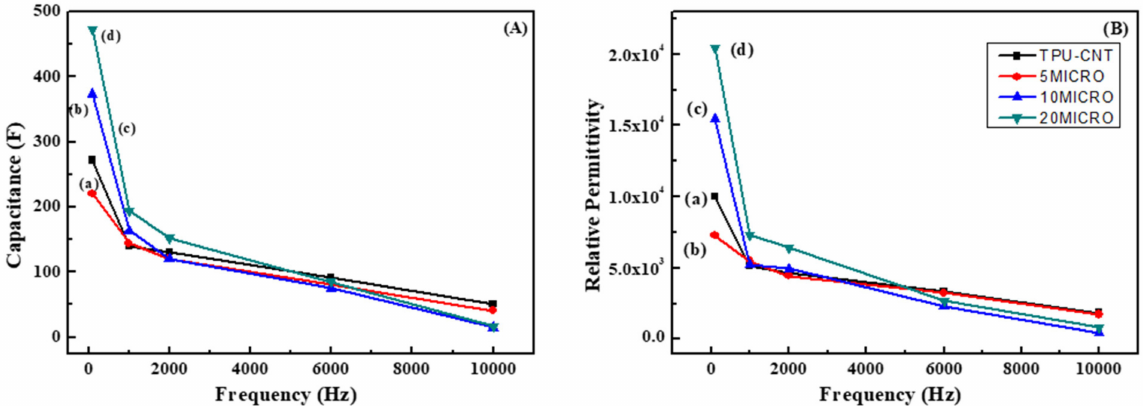
Figure 7 . Capacitance ( A ) and relative permittivity ( B ) of ( a ) TPU-MWCNT, ( b ) TPU-(MWCNT- PMMA) (5 µ m), ( c ) TPU-(MWCNT-PMMA) (10 µ m) and ( d ) TPU-(MWCNT-PMMA) (20 µ m).